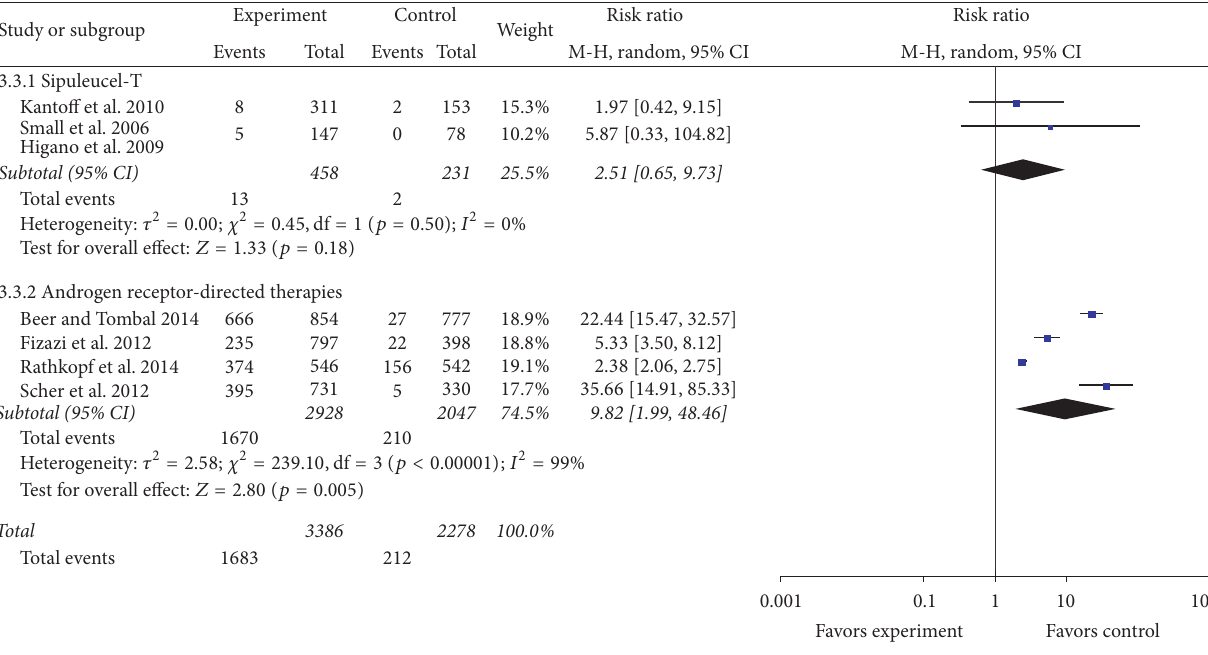
Figure 4: Forest plot of risk ratio of reduction of prostate-specific antigen ≥ 50% of sipuleucel-T and androgen receptor-directed therapies compared with placebo in men with castration-resistant prostate cancer. The bars with squares in the middle represent 95% confidence intervals (95% CIs) and RRs. The central vertical solid line indicates the RRs for null hypothesis. The size of the diamonds represents the weight for the random-effect model in the